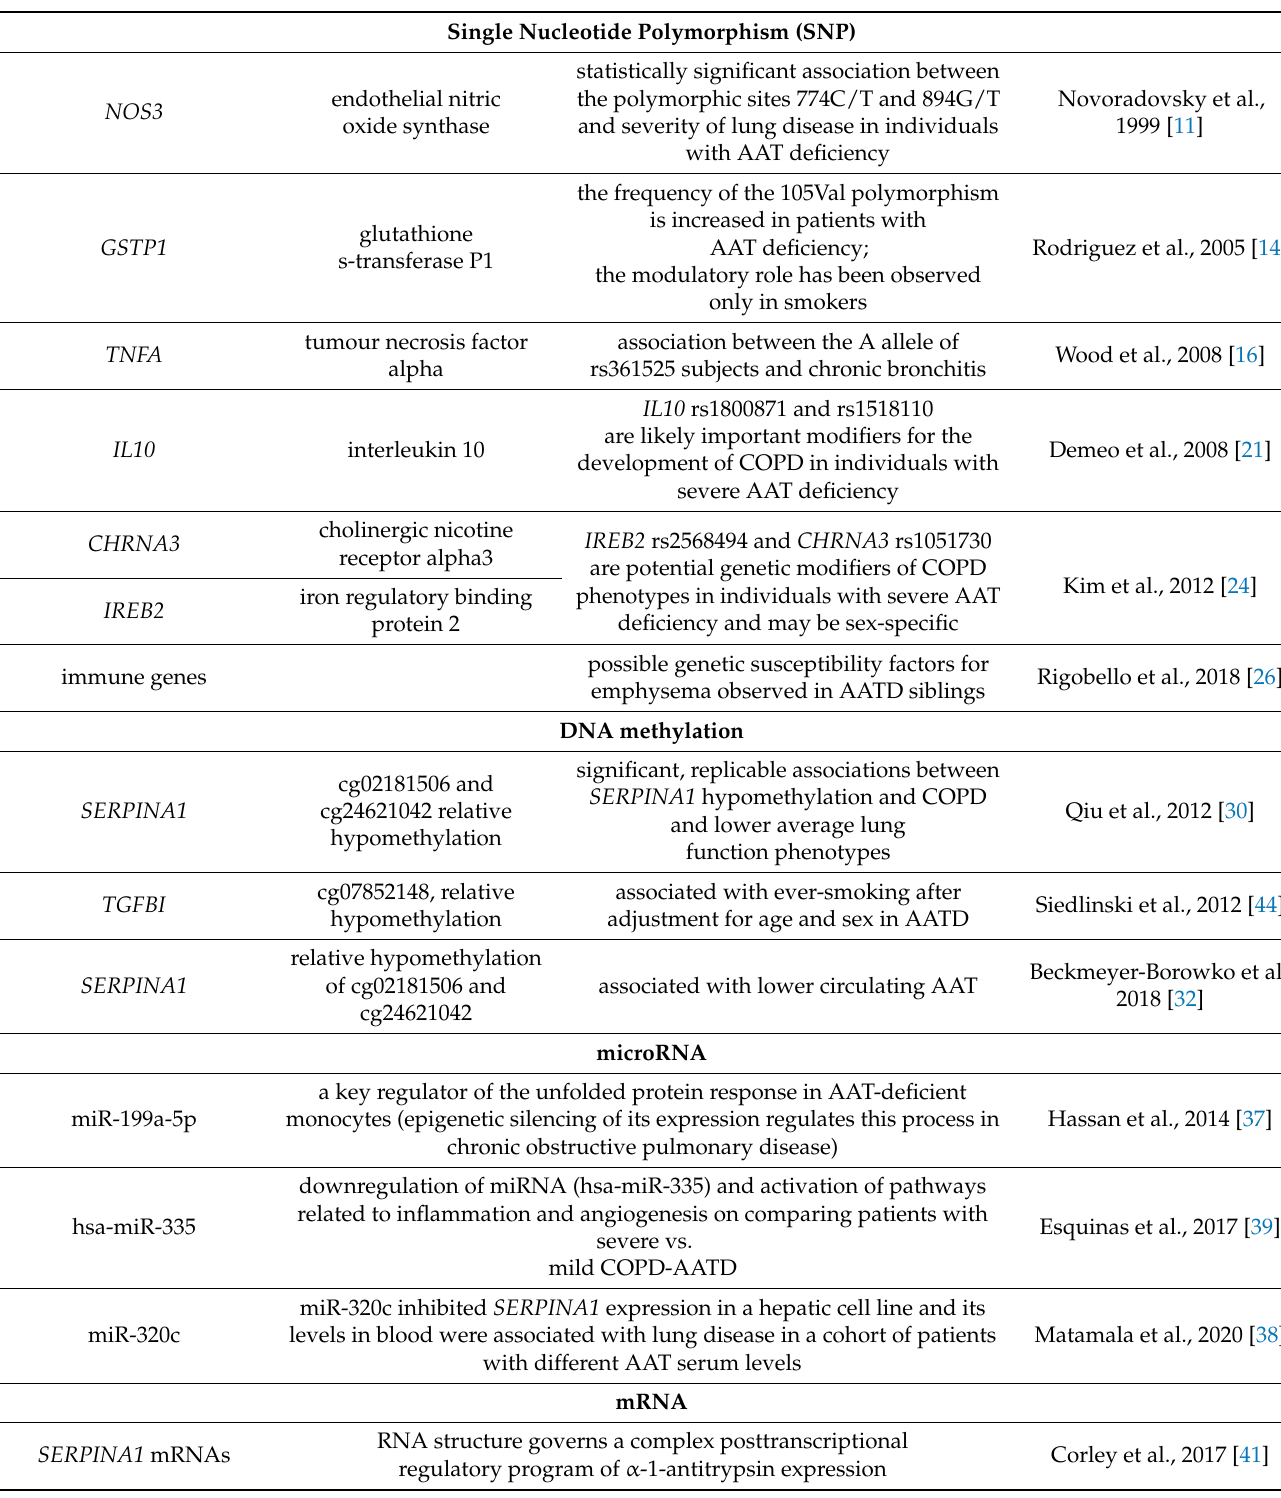
Table 1. Putative genetic contributors to pulmonary decline in AATD and/or SERPINA1